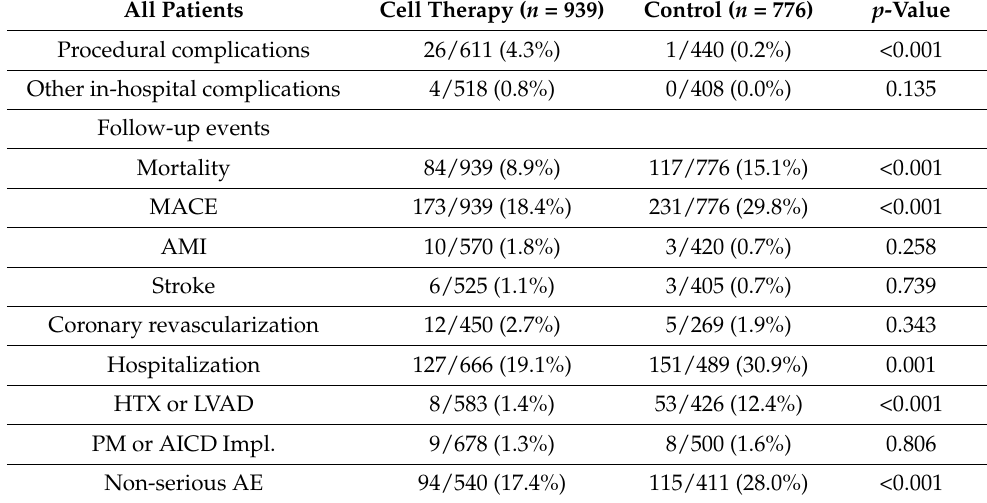
Table 3. Primary and secondary clinical safety endpoints, complications and adverse